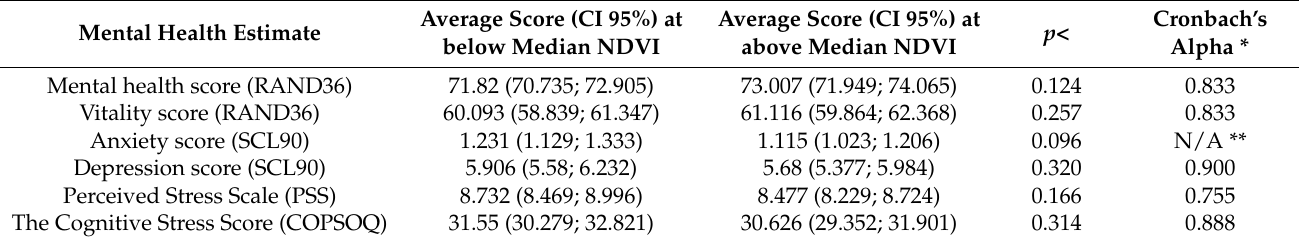
Table 7. Average values of the mental health estimates stratified by NDVI exposure levels below and resp. above the median level within 50 m buffers (CI—confidence